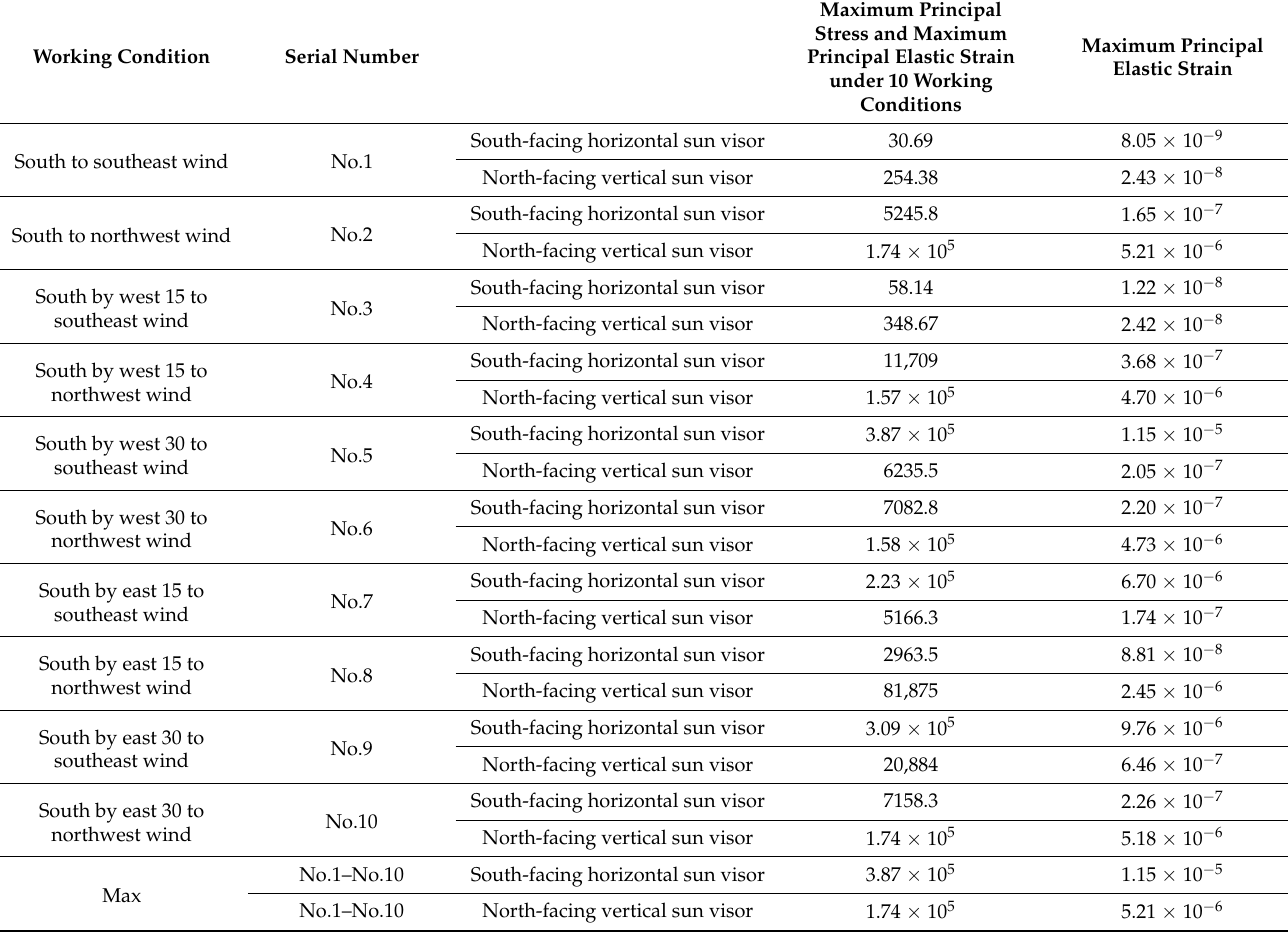
Table 3. Maximum principal stress and maximum principal elastic strain under 10 working